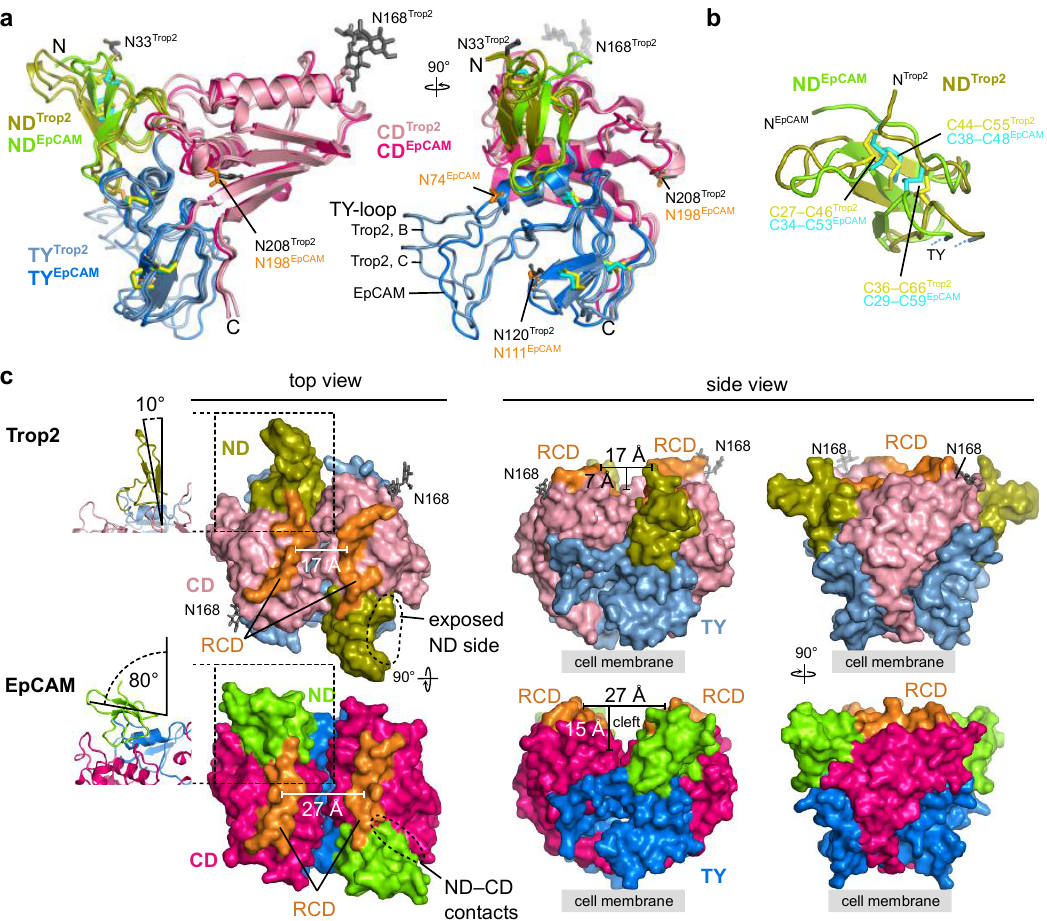
Figure 5. Comparison of Trop2 and EpCAM ectodomain subunit structures and dimers. As EpCAM structure PDB ID 4MZV was used [6]. Trop2 domain color-coding is the same as in Figure 3, and ND, TY and CD domains of EpCAM are shown as chartreuse, marine blue and dark pink, respectively. RCD region (H227–Q239 in EpCAM, Q237–R247 in Trop2) is shown in orange. ( a ) Superposition of two chains of Trop2 ectodomain (chains B and C) with EpCAM ectodomain structure (PDB ID 4MZV) shown in two orientations depicts different conformations of the TY-loop. Disulfide bridges are shown as sticks (yellow for Trop2, cyan for EpCAM). ( b ) Superposition of ND of Trop2 (olive) and EpCAM (chartreuse) shows conserved pattern of three closely located disulfide bridges (color-coded the same as in ( a )). ( c ) Surface representation of Trop2 and EpCAM ectodomain dimer in three different orientations demonstrates significant difference in relative orientation of the ND, different position of the RCD and a much narrower cleft in the membrane-distal region of Trop2 as compared to EpCAM. Relative orientation of the ND was defined as the angle between β-sheet of the ND and the dimer interface plain (left, ribbon representation of the region marked by rectangle). Cleft width was defined as the length of the vector (parallel to the membrane) between central parts of the juxtaposed RCDs, and cleft depth as the length of the vector (perpendicular to the membrane) between the most membrane-distal part of the dimer and the touching point of the subunits in the middle part of the dimer.